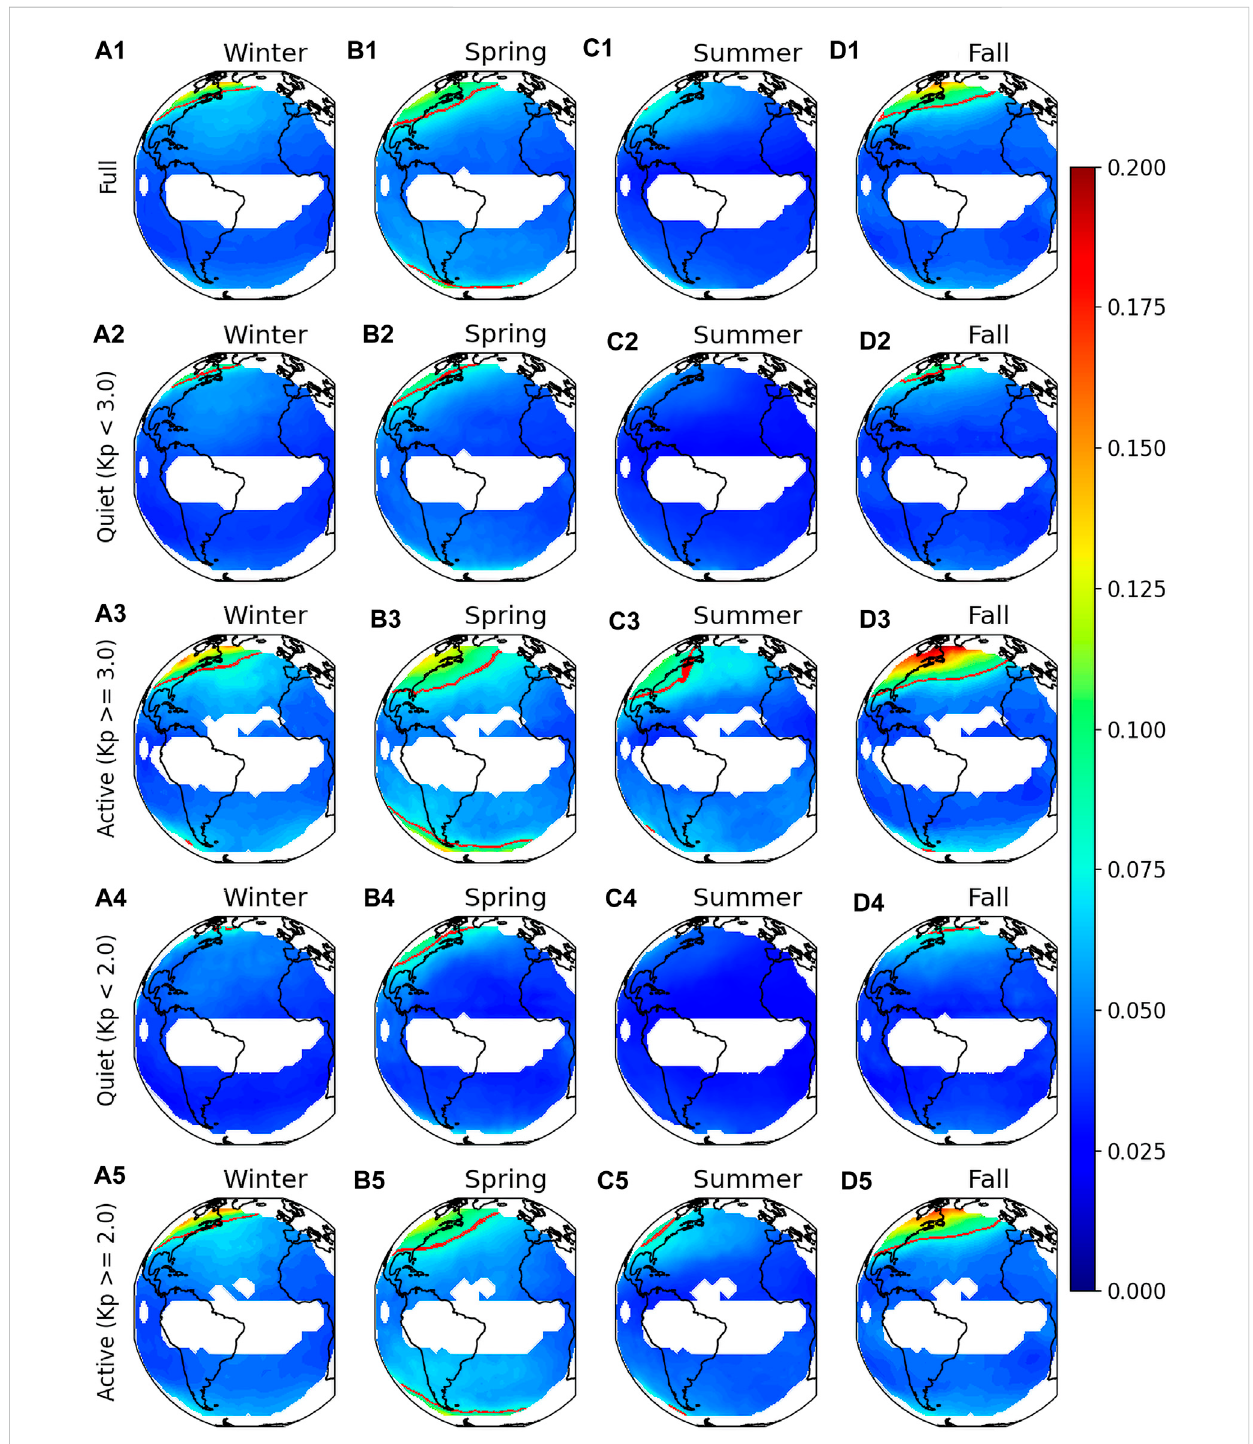
FIGURE 3 Same as Figure 2 except for relative stds. (A1 – D1) are the relative stds of O/N 2 ratios for the four seasons using all reliable data. (A2 – D2) , (A3 – D3) , (A4 – D4) , and (A5 – D5) are the same except for the stds calculated using data with Kp < 3.0, Kp ≥ 3.0, Kp < 2.0, and Kp ≥ 2.0, respectively. Blank areas are regions where more than half of the daily O/N 2 points had uncertainties exceeding 0.30. Red lines are the contours of